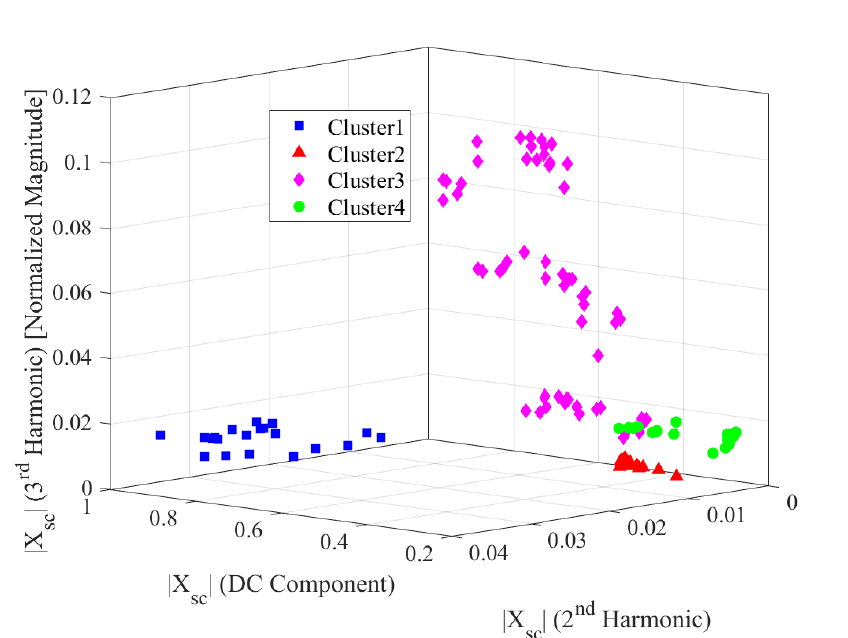
Figure 10. Scatter plot of stator current harmonics as feature